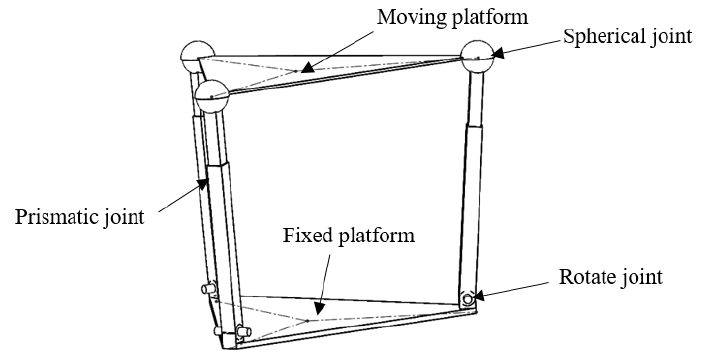
Figure 2. 3-RPS parallel compensate platform.